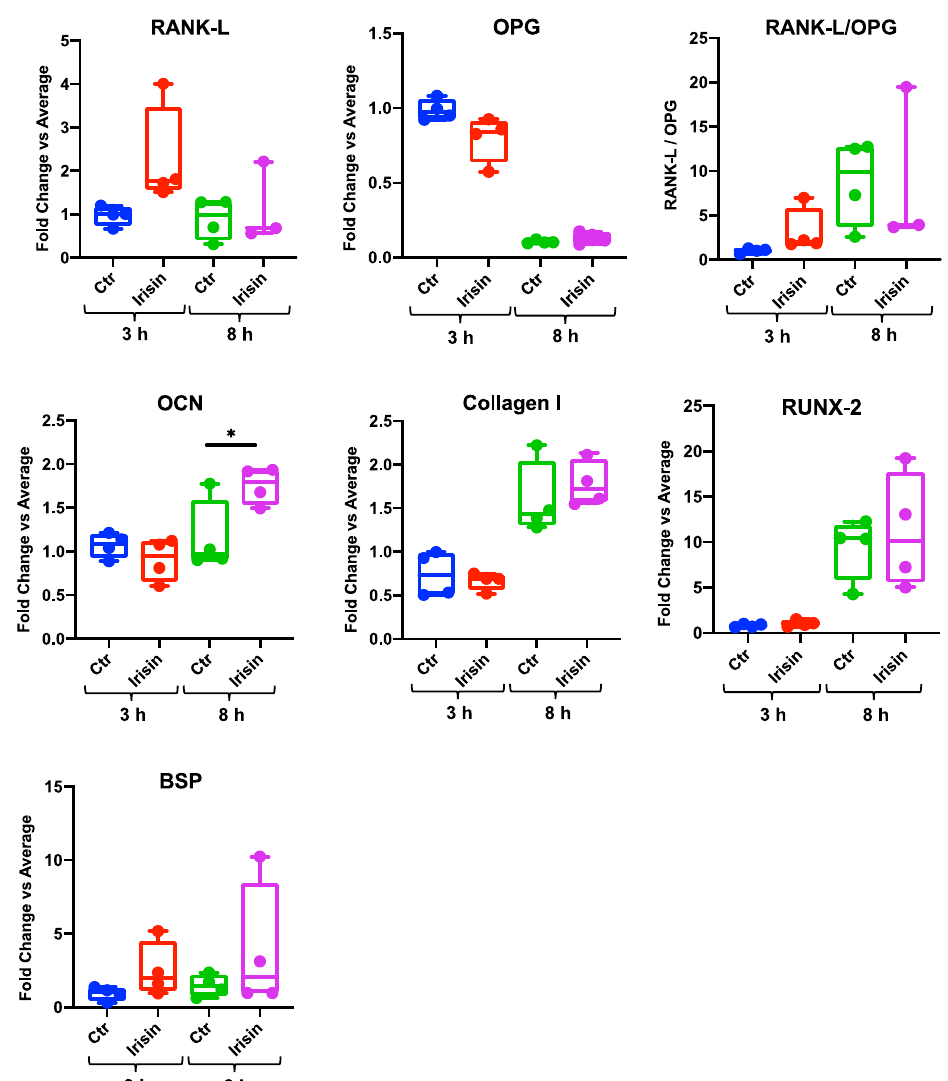
Figure 3. Effects of irisin on the expression of osteoblast markers at mRNA level. mRNA expression levels of osteoblast marker genes (RANK-L, osteoprotegerin (OPG), osteocalcin (OCN), collagen I, RUNX-2, and bone sialoprotein (BSP)) were assayed (qPCR) after 3 and 8 h of stimulation with irisin. The graph shows that the treatment significantly enhanced the expression of the osteoblast marker OCN. Expression was normalized to the average of β -actin, β 2 microglobulin (B2M), and GAPDH levels for each reaction. Graphs represent data as box-and-whisker plots with median and interquartile ranges, from max to min, of four independent experiments performed in triplicate. * p < 0.05 compared to Ctr. Student’s t -test was used for single